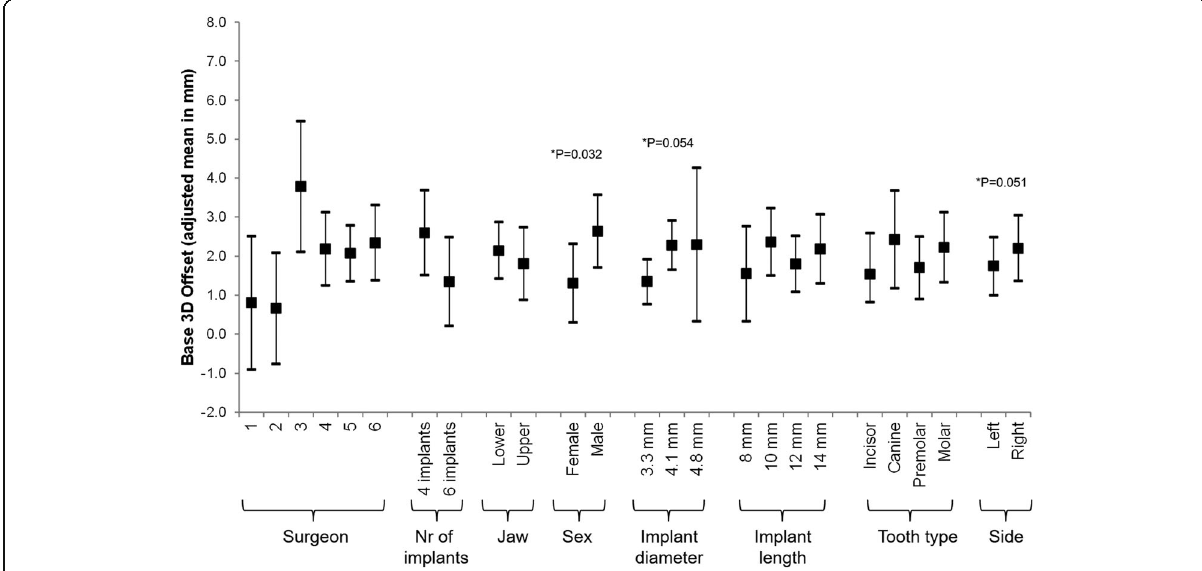
Fig. 2 Multivariable association between Base 3D Offset and all considered risk factors. A mixed regression model was used. The effect of the patient was introduced in the model as a random